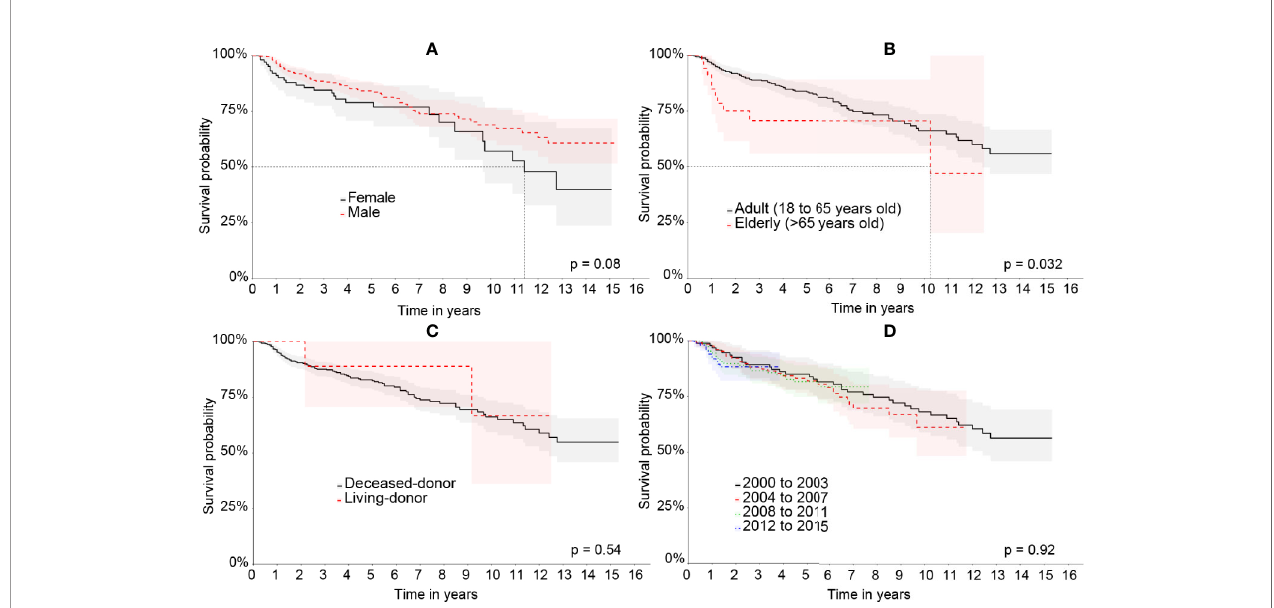
FIGURE 5 | Kaplan-Meier ’ s liver graft survival curve in the Matched cohort comparing: (A) patient ’ s sex, (B) age group, (C) type of transplant, and (D) period of